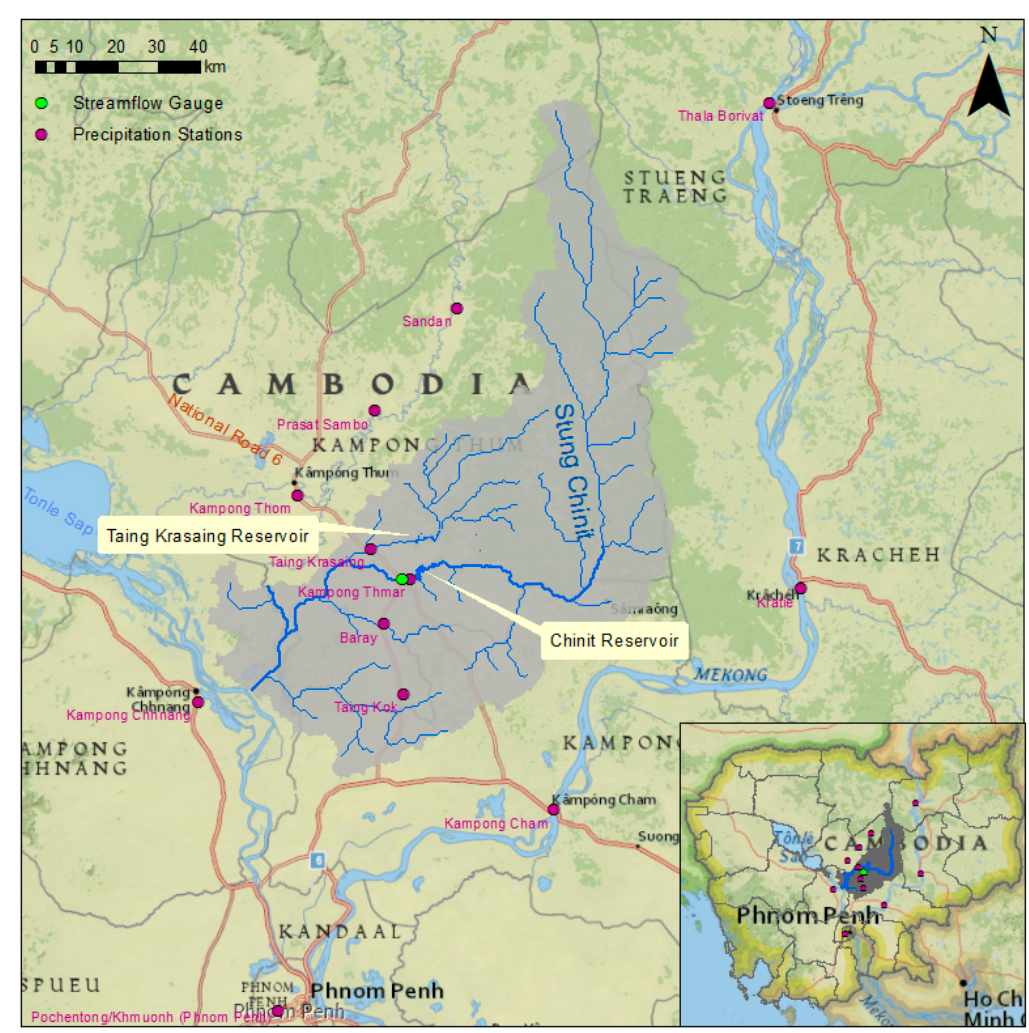
Figure 1. Map of the Stung Chinit watershed, including two reservoirs, with precipitation stations and streamflow gauges used in this study. The inset map shows the watershed’s location within Cambodia.